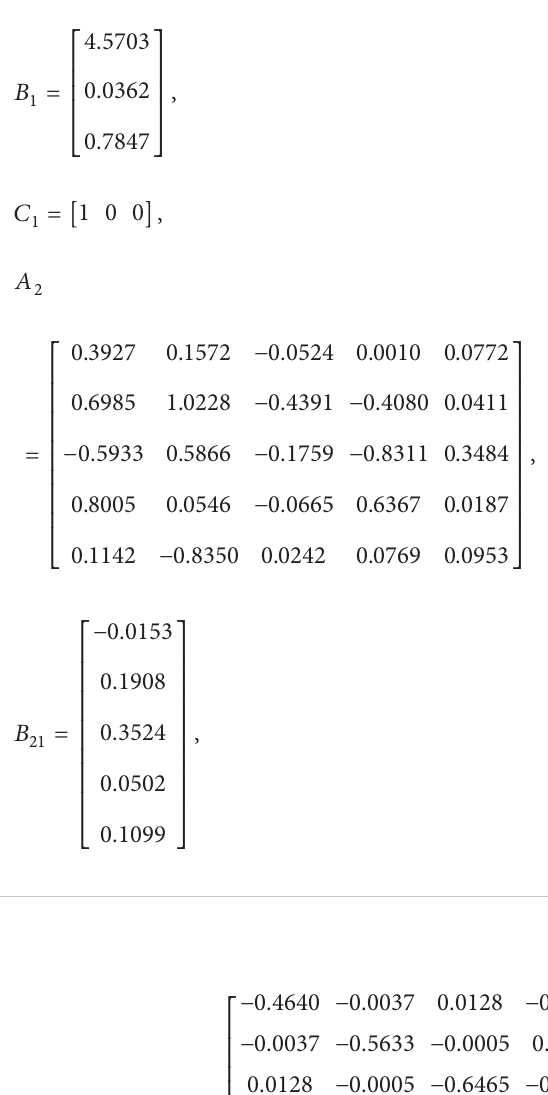
0.0233 −0.0263 −0.7761 −0.0993 0.0161 0.1228